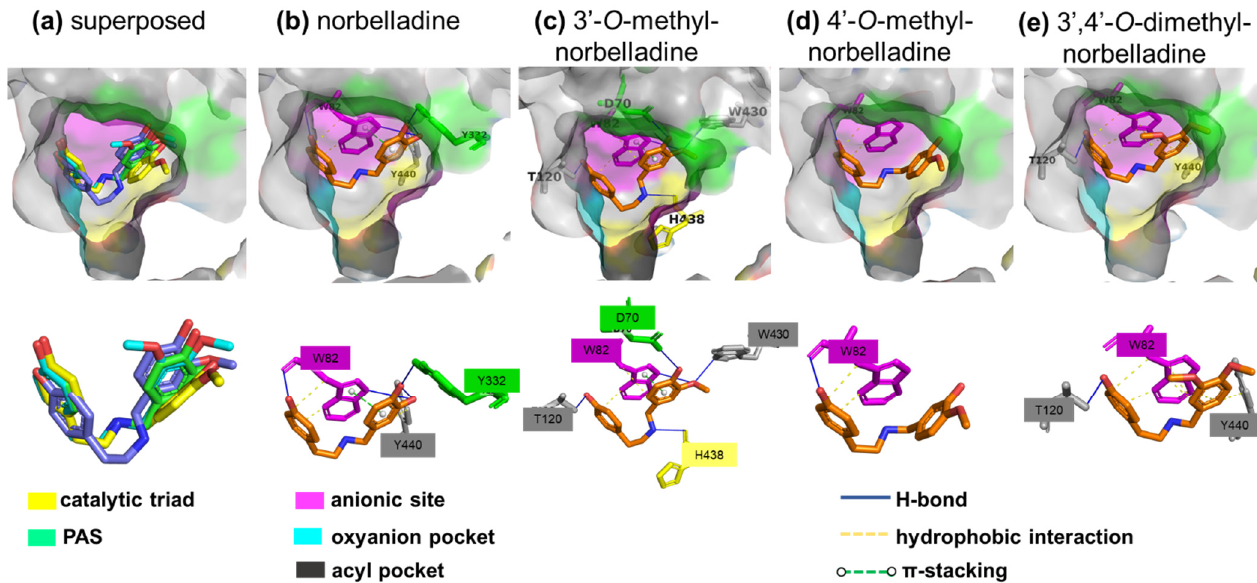
Figure 6. Prediction of norbelladine derivatives’ interactions with butyrylcholinesterase. Grey surface representation of BuChE (4BDS) active site with key subsites highlighted in different colors (catalytic triad is in yellow, pre-anionic site (PAS) is in green, anionic site is in pink, oxyanion pocket is in turquoise, and the acyl pocket is in dark grey). ( a ) Superimposition of docked ligands in the BuChE active site (norbelladine is in green, 3 ′ - O -methylnorbelladine is in purple, 4 ′ - O -methylnorbelladine is in yellow, and 3 ′ ,4 ′ - O -dimethylnorbelladine is in turquoise). ( b ) Non-covalent (H-bond, hydrophobic, and P-stack) interactions of norbelladine with Trp82 from the anionic site, Tyr332 from the PAS, and Tyr440 from the binding site. ( c ) Non-covalent interactions of 3 ′ - O -methylnorbelladine with W82 from the anionic site, Asp70 from the PAS, His438 from the catalytic triad, and Trp430 from the binding site. ( d ) Non-covalent interactions of 4 ′ - O- methylnorbelladine with Trp82 from the anionic site. ( e ) Non-covalent interactions of 3 ′ ,4 ′ - O -dimethylnorbelladine with Trp82 from the anionic site and Thr120 and Tyr440 from the binding site.